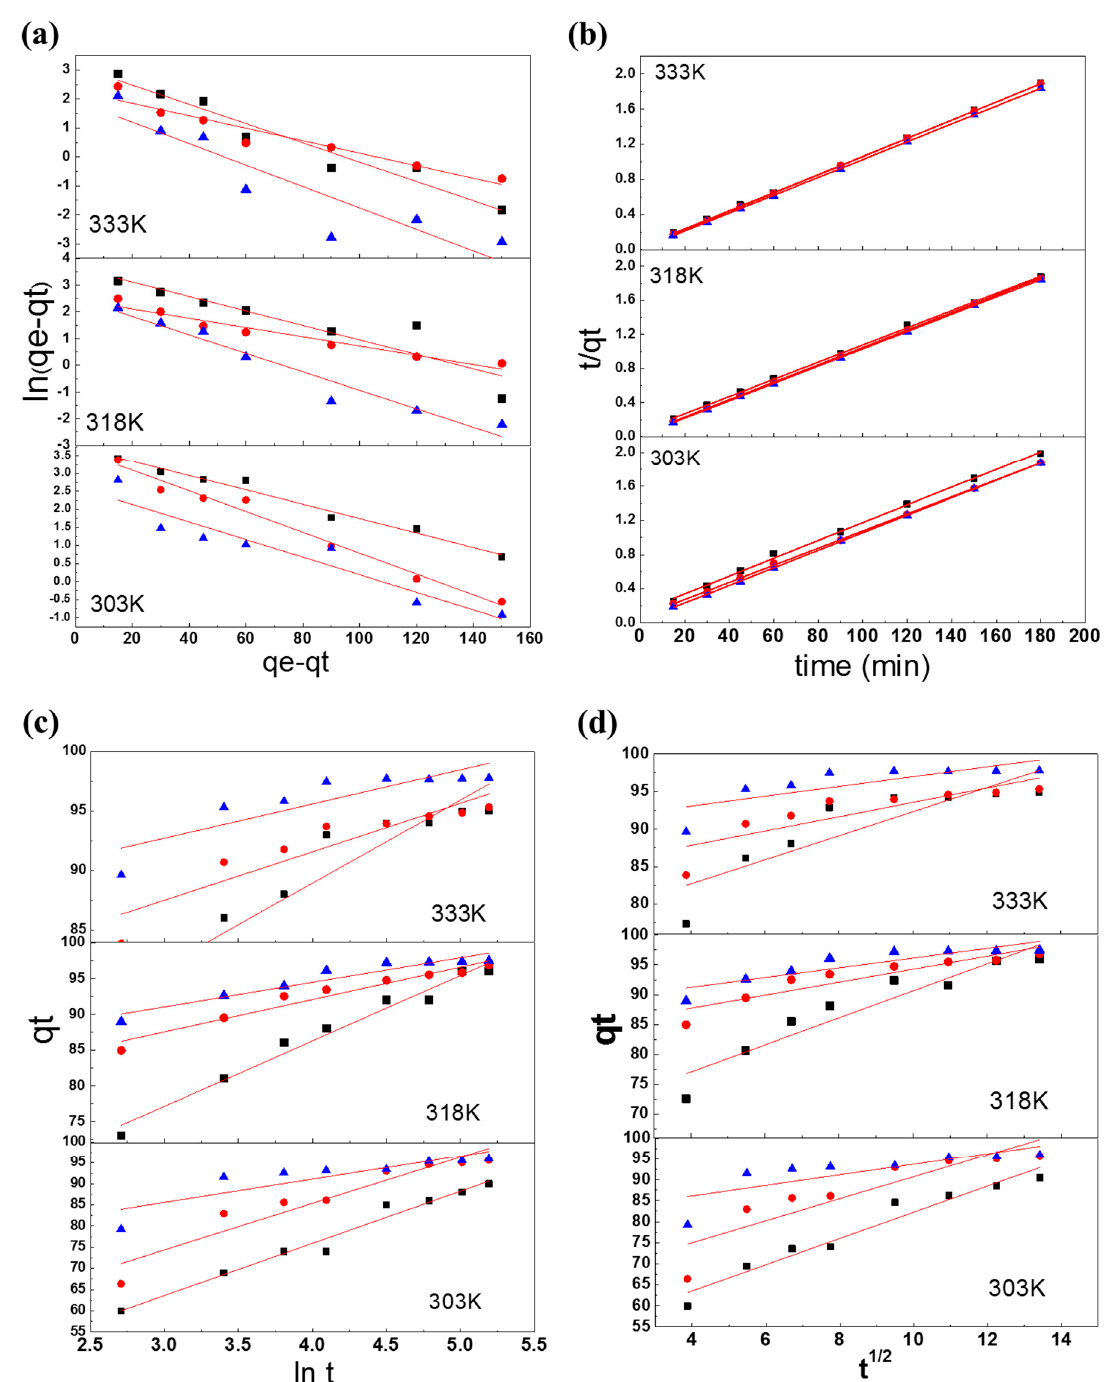
Figure 6. Adsorption kinetics models of the three adsorbents at different temperatures: ( a ) pseudo-first-order model; ( b ) pseudo-second-order model; ( c ) Elovich model; and ( d ) Weber–Morris model ( ■ α -chitosan, ● β -chitosan, and ▲ BCCT). Table 3. Kinetic models of the adsorbents for the Reactive Blue 221 dye adsorption.